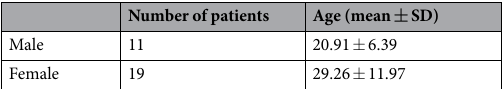
Table 1. Sex, number, and age of patients.